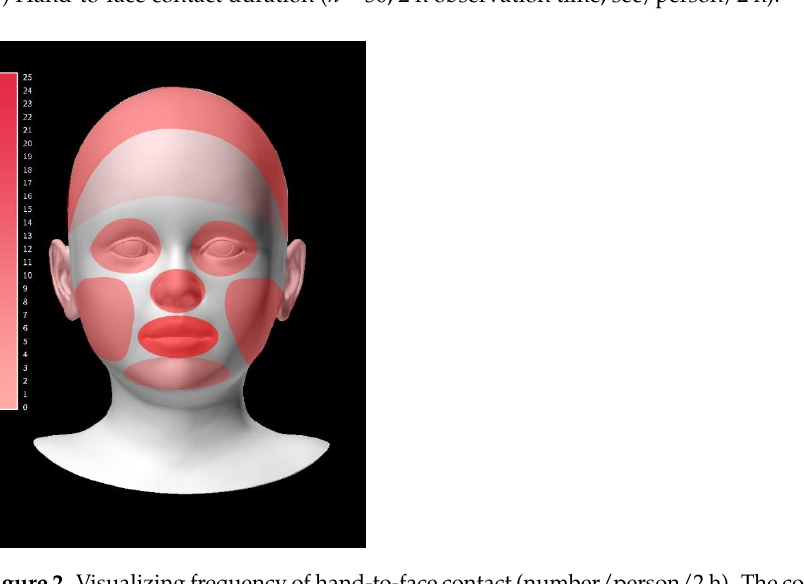
Figure 3. Density distribution of frequency and duration in hand-to-face contact by gender. Density of contact frequency = number/contact frequency-group width; Density of contact duration = num- ber/contact duration-group width. 3.4. Differences in CF and CD by the Child’s Age and Gender There were no statistically significant differences in the frequency and duration of mucosal contact according to age. The mucosal and non-mucosal contact frequencies were significantly different according to gender ( p = 0.027 and p = 0.030, respectively). Boys